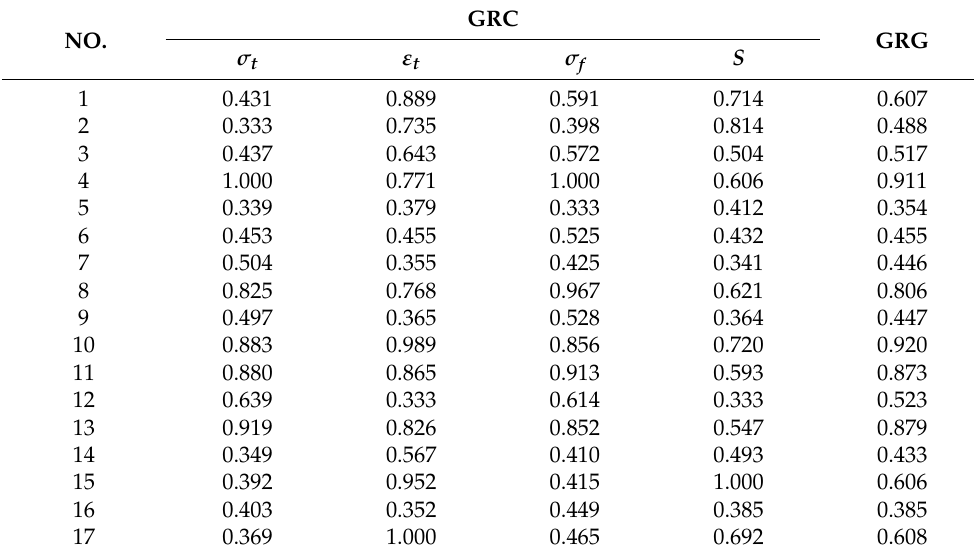
Table 6. Gray correlation degree calculation results.